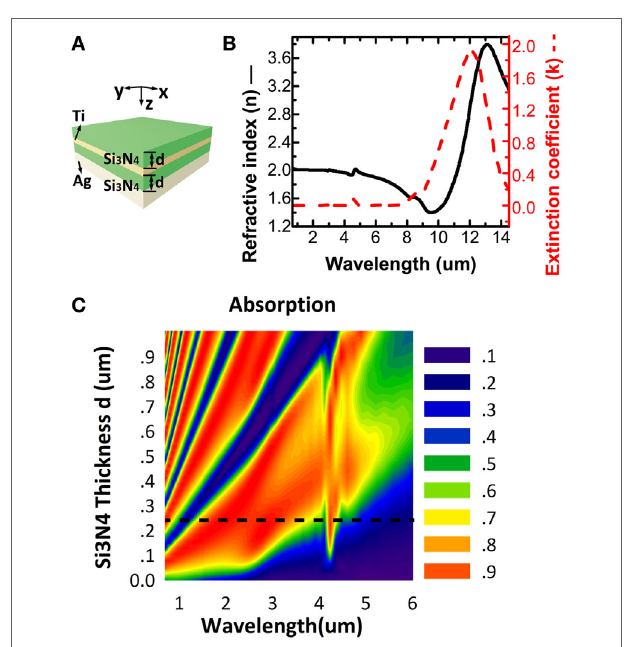
FigUre 2 | (a) Schematic of the impedance-matched structure. (B) The measured optical constants of the Si 3 N 4 layer deposited by plasma-enhanced chemical vapor deposition. (c) The simulated absorption of the impedance- matched structure with respect to the Si 3 N 4 layer thickness.